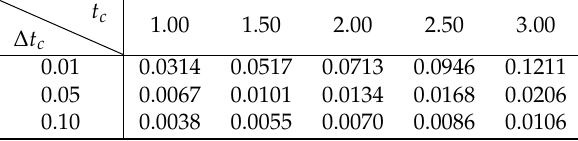
Table 2. Computation time of the proposed MPC